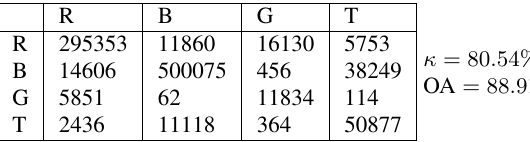
Table 3. Confusion matrix obtained using